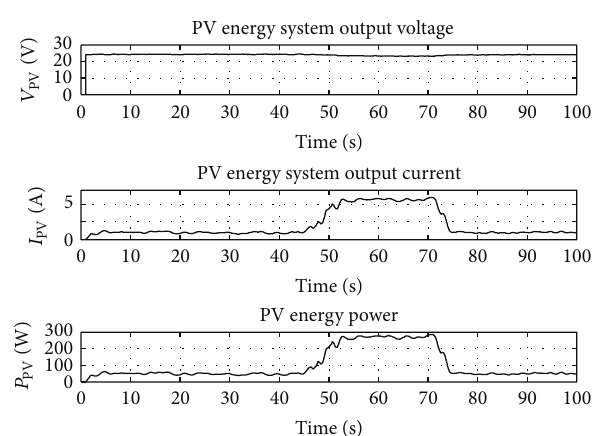
Figure29:Current,voltage,andpowerchangeofPVenergysystem.